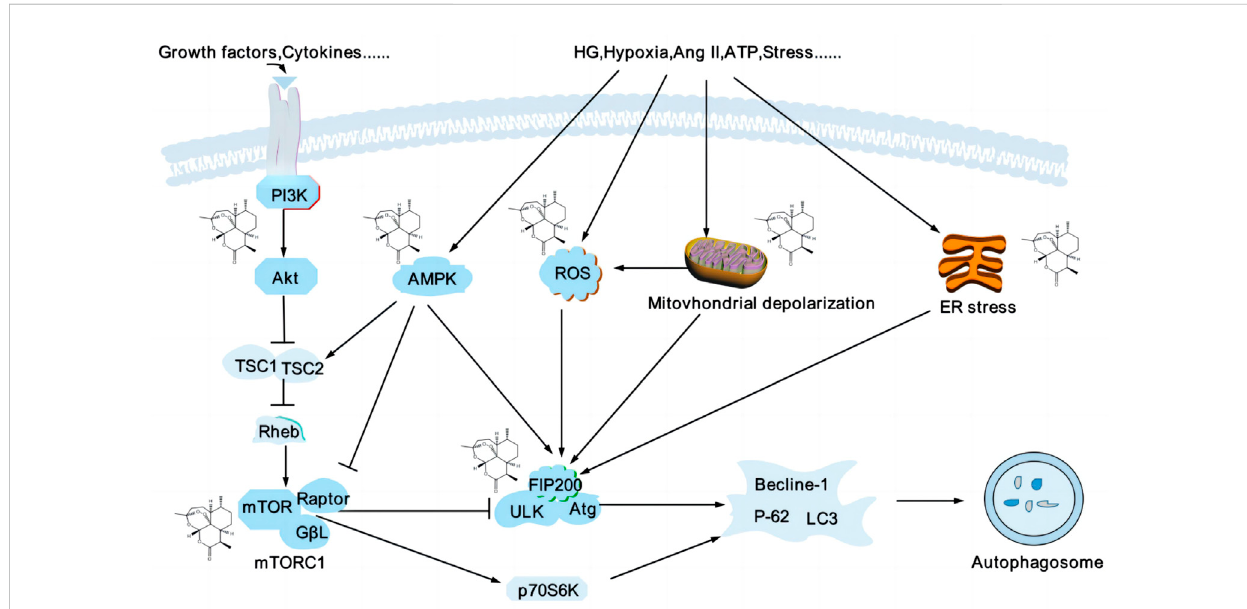
FIGURE 4 Artemisinin and its derivatives modulate autophagy to delay kidney injury. Podocyte autophagy is affected by various factors, such as in fl ammatory factors, oxidative stress, mitochondrial depolarization, and endoplasmic reticulum stress, etc. mTOR and AMPK are signi fi cant regulators of autophagy, and mTORC1 is a negative regulators of autophagy, inhibiting autophagy by regulating the ULK1 complex. AMPK can promote autophagy by inhibiting mTORC1 or directly phosphorylating the expression of several autophagy-related proteins, such as ULK1, Atg, and beclin1. Artemisinin and its derivatives regulate related targets (structural formula of artemisinin) and regulate the process of autophagy. PI3K, phosphatidylinositol 3-kinase; AKT, protein kinase B; mTOR, mammalian target of rapamycin; AMPK, adenosine monophosphate-activated protein kinase; ULK, unc-51-like kinase; Atg, autophagy-related genes; ROS, reactive oxygen species; HG, high glucose; Ang II, angiotensin II; ATP, adenosine triphosphate; ER, endoplasmic reticulum; LC3, microtubule-associated protein light chain